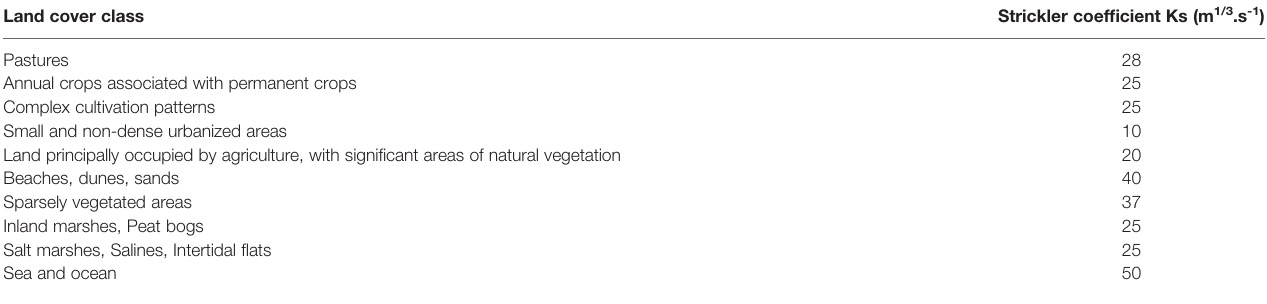
TABLE 2 | Simpli fi ed classi fi cation based on Corinne land cover data and Strickler coef fi cients associated. Adapted from Papaioannou et al. (2018). Land cover